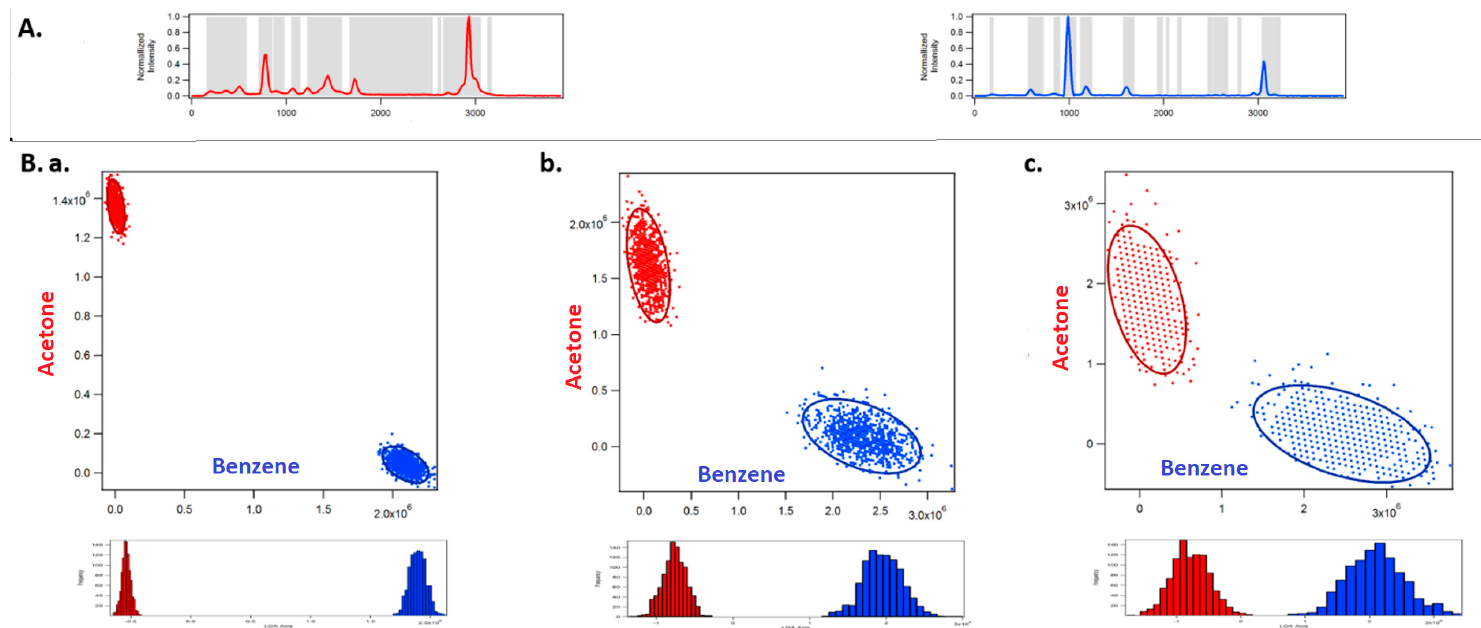
Figure 3. The figure shows the classification of acetone and benzene using optimized binary compressive detection (OBCD) filtering. Panel ( A ) shows the normalized spectra of acetone (red, top left) and benzene (blue, top right) collected to be used as training spectra to generate OBCD filters. This panel also shows OBCD filters in gray, i.e., the OB wavelengths that are multiplexed onto one PMT. Sub panels ( a – c ) in Panel ( B ) correspond to 1000 OBCD classification of acetone and benzene in 1 ms using 30 mW, 3 mW, and 1 mW laser power at the sample, respectively.